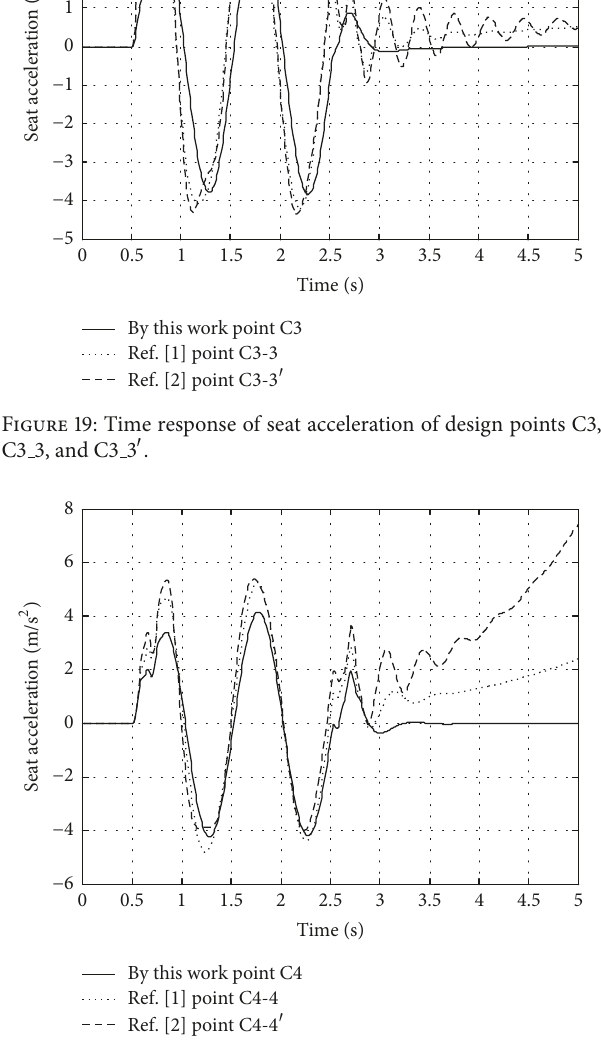
Figure 18: Time response of seat acceleration of design points C2, C2 2, and C 2 󸀠 .